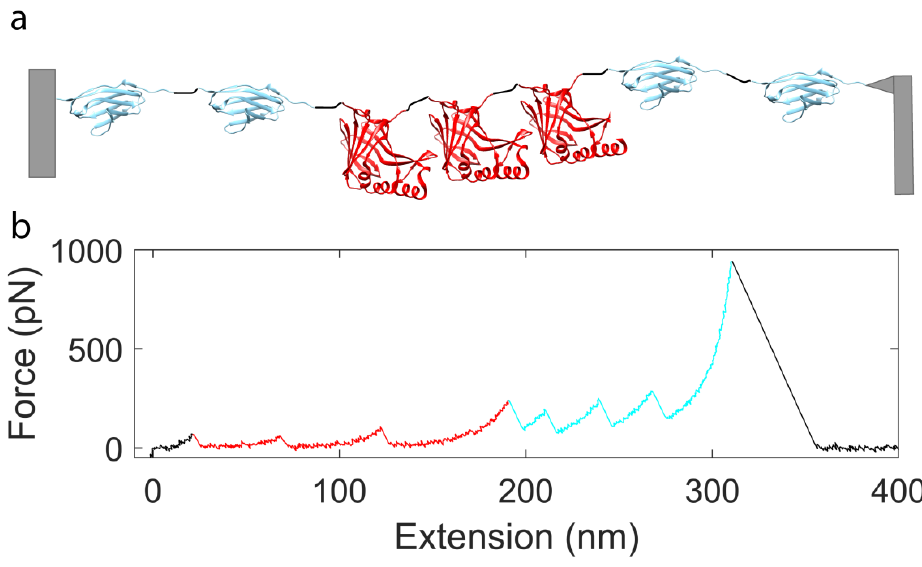
Figure 2. ( a ) Depiction of the I91 2 -NanoLuc 3 -I91 2 construct. On the far left is the surface and on the far right is the cantilever. In between, we can see with cyan the I91 domain (PDB file 1WAA) and with red the NanoLuc proteins (PDB file 5IBO). The different proteins were connected with short linkers (4–5 residues). ( b ) A full trace of the I91 2 -NanoLuc 3 -I91 2 construct. Different parts of the unfolding curves are color matched with the respective